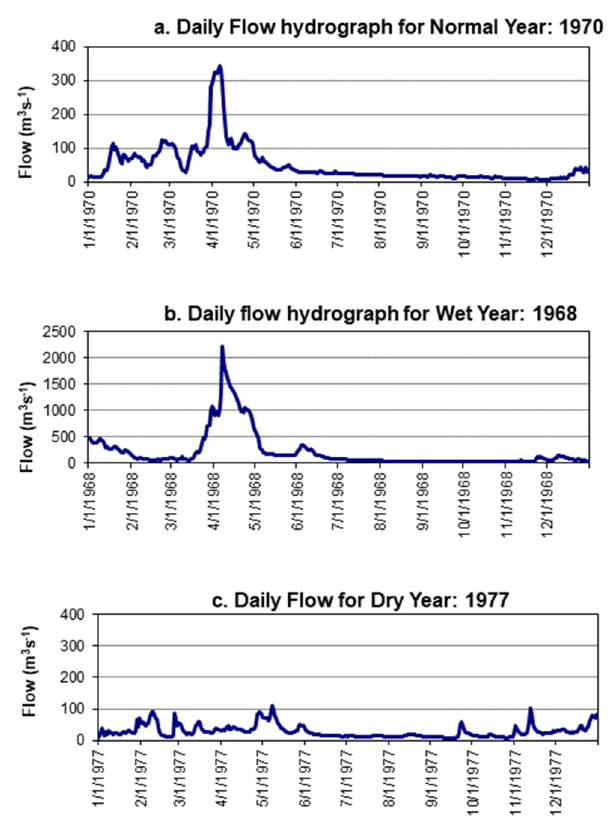
Figure 4. Daily flow hydrographs (m 3 /s) for ( a ) normal, ( b ) wet and ( c ) dry years at Gama Gate, Wami River,